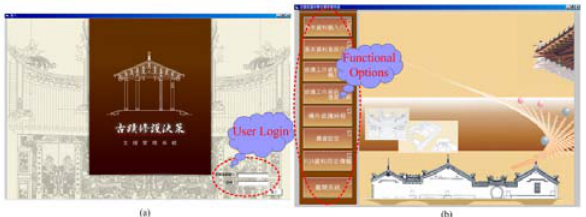
Fig. 12. The server sub-system: user login (a); main page